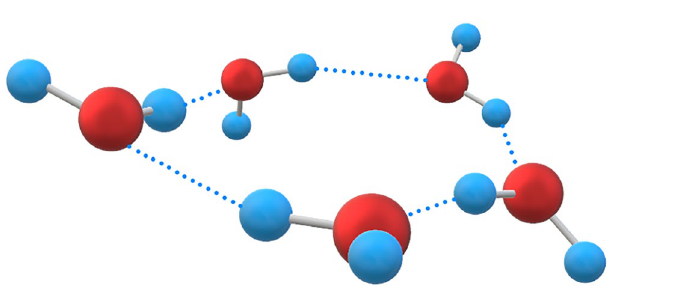
Figure 9. Frequency domain spectrum ( a ) and absorption coefficient spectrum ( b ) of NH 4 Cl solution with different time electric field applied externally.